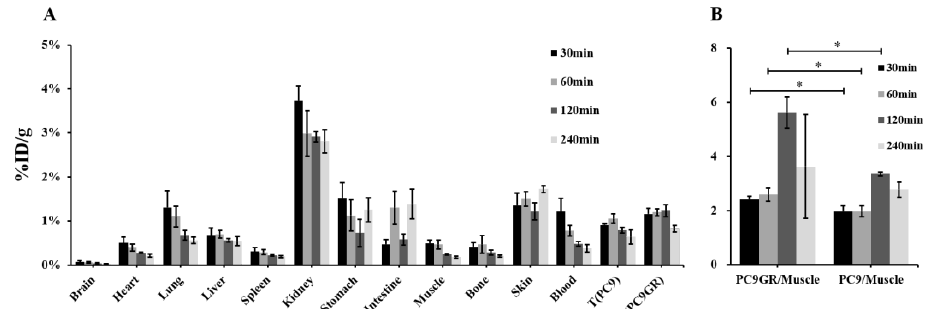
Figure 8. ( A ) PC9 and PC9GR tumor-bearing BALB/c nude mice biodistribution studies of 99m Tc- HYNIC-ADH-1 at 30, 60, 120 and 240 min p.i. Values are expressed as %ID/g. ( B ) Tumor to muscle ratio of 99m Tc-HYNIC-ADH-1 in tumor-bearing mice (* P < 0.05). The ratios of tumor/non-tumor (muscle, liver and kidney) at each time point are listed in Table 2. In tumor/muscle, the PC9GR/muscle ratio was higher than that of PC9 at each time point, and both of them peaked at 2h. The difference between PC9GR/muscle and PC9/muscle at 30min, 1h and 2h was statistically significant ( P < 0.05, Figure 8B). Table 2. Tumor/non-tumor ratio of 99m Tc-HYNIC-ADH-1 in tumor-bearing mice (x ± SD). Time T/NT 30min 1h 2h PC9GR/Muscle 2.41 ±